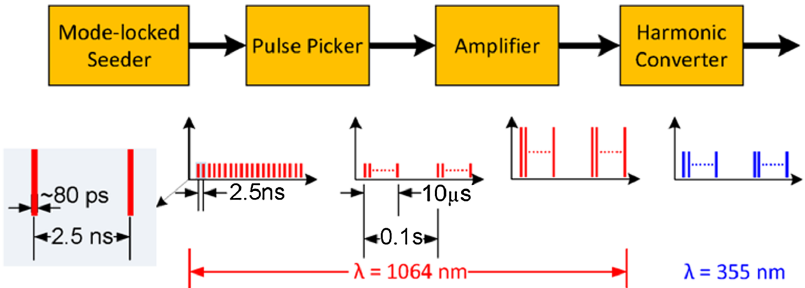
FIG. 19. Block diagram of the burst-mode laser system illustrates the micro- and macropulse trains and their amplification and conversion